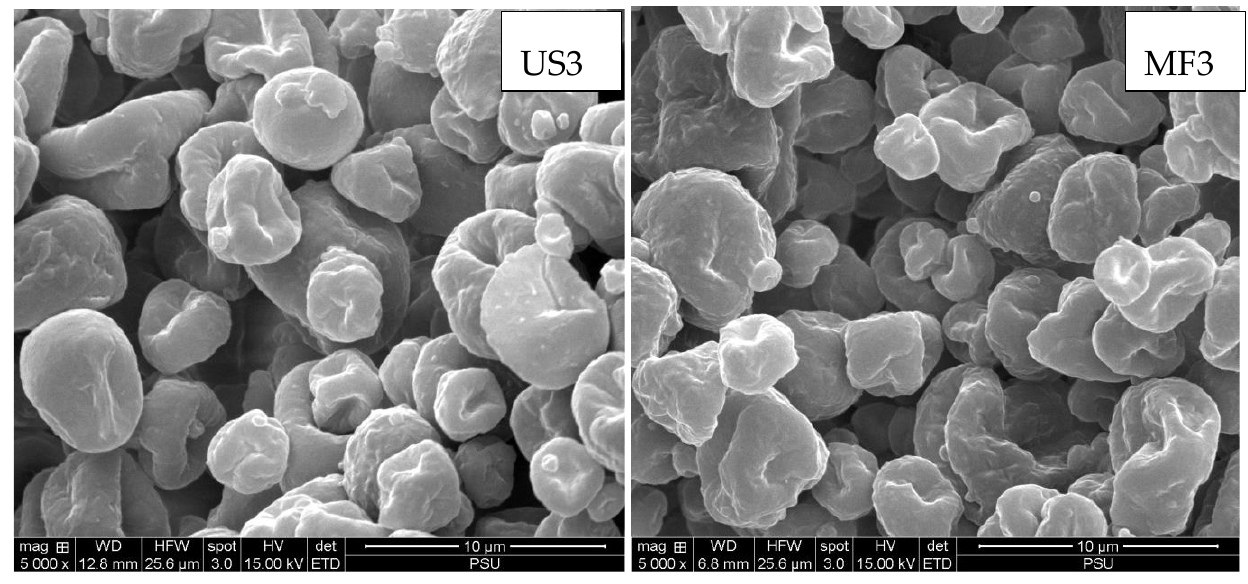
Figure 1. Scanning electron microscopic images of spray-dried microcapsules with KBPI and KC (1:0.1, w/w) as wall materials loaded with different amounts of SO. SO, shrimp oil, KBPI, kidney bean protein isolate; KC, κ -carrageenan; US1, ultrasonicated KBPI-KC-SO microcapsules containing 0.1% SO; US2, ultrasonicated KBPI-KC-SO microcapsules containing 0.5% SO; US3, ultrasonicated KBPI-KC-SO microcapsules containing 1% SO; MF1, microfluidized KBPI-KC-SO microcapsules containing 0.1% SO; MF2, microfluidized KBPI-KC-SO microcapsules containing 0.5% SO; MF3, microfluidized KBPI-KC-SO microcapsules containing 1% SO.